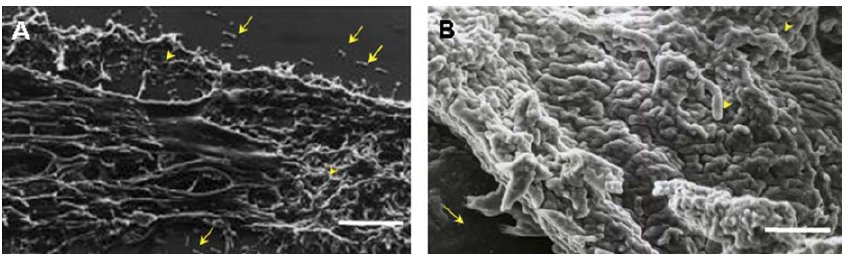
Figure 8. No M. ulcerans ECM Is Detected in Culture Supplemented with Organic Extracts of Algae or in Salivary Glands of Water Bugs (A) Scanning electron micrograph of the accessory salivary glands of N. cimicoides showed that the bacilli (wild-type strain) are either alone (yellow arrows) or in clusters (yellow arrowheads) lacking ECM. Scale bar: 10 l m. (B) M. ulcerans aggregate cultured with organic matter extracted from Rhizoclonium sp. The bacilli form large clusters that are not covered by ECM and that adhere to aquatic plant surface (arrow). Scale bar: 20 l